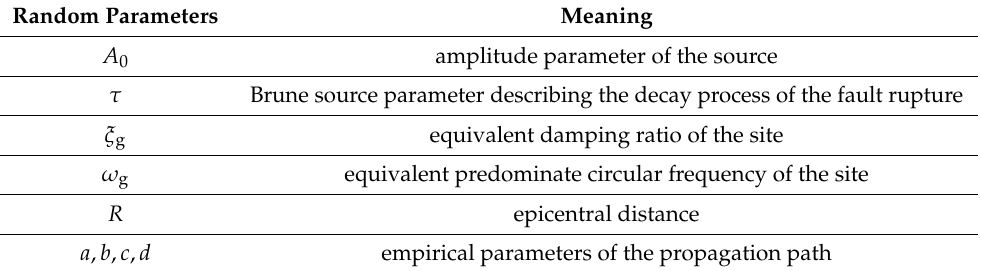
Table 1. Random parameters of the stochastic semiphysical model of seismic ground motions. Random